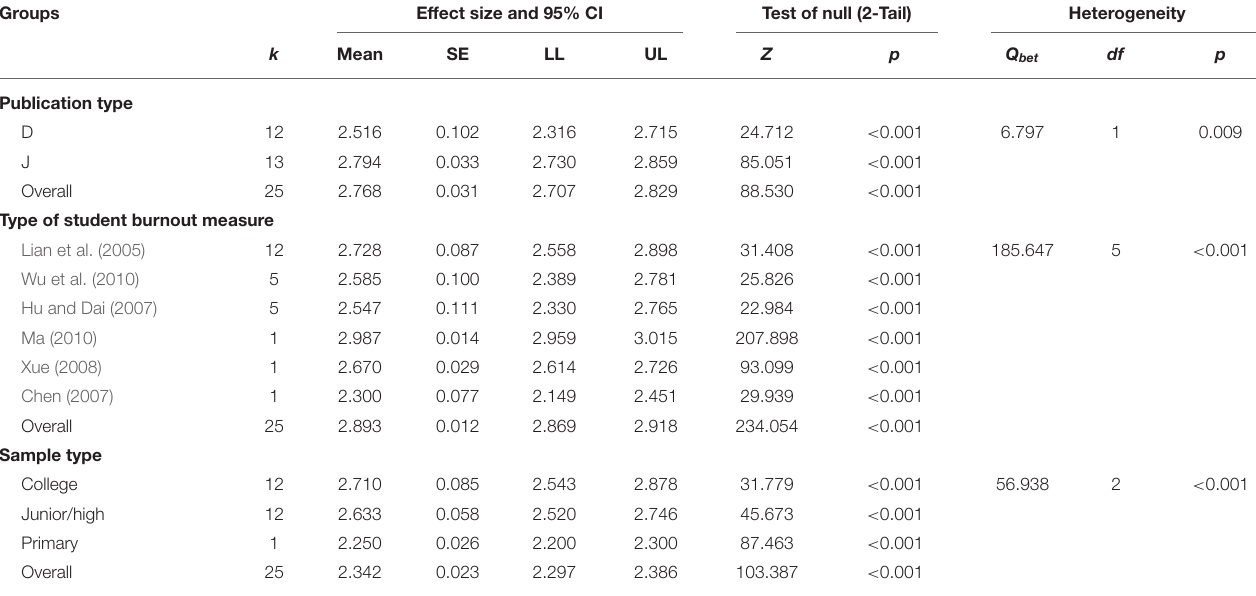
TABLE 5 | Moderations on the means of student